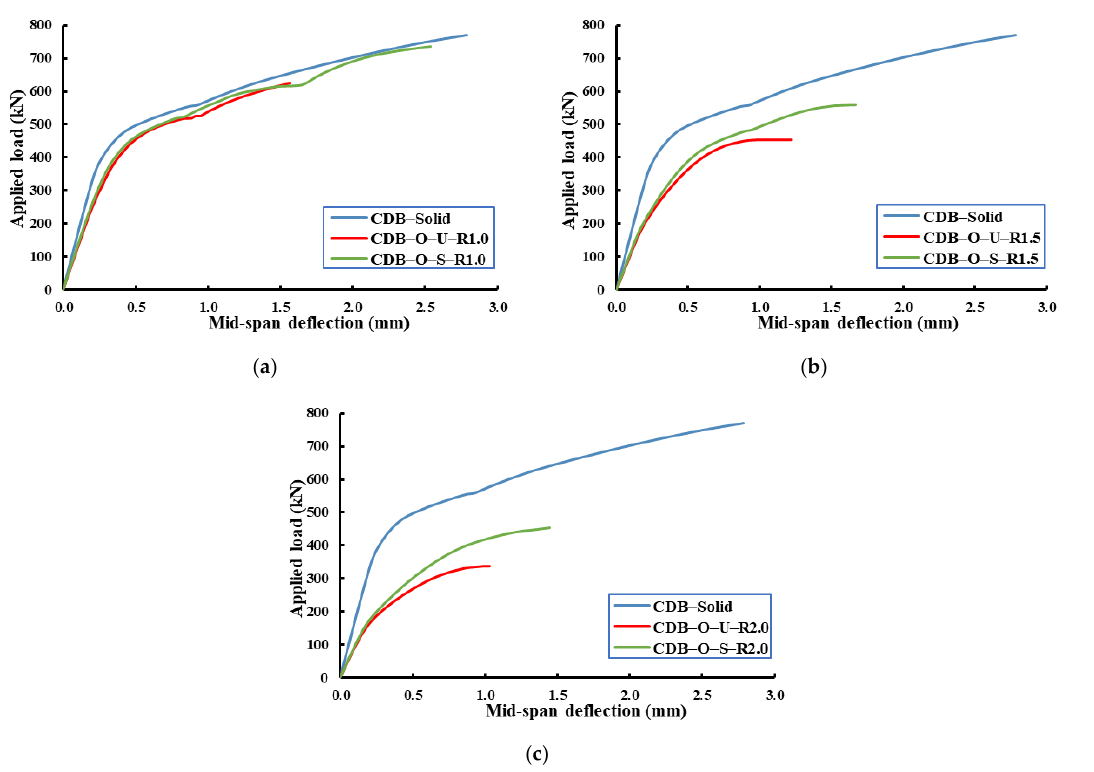
Figure 13. Effect of the ratio of the opening dimensions on the behavior of RCCDBs. ( a ) Un-strengthened beams; ( b ) strengthened beams.